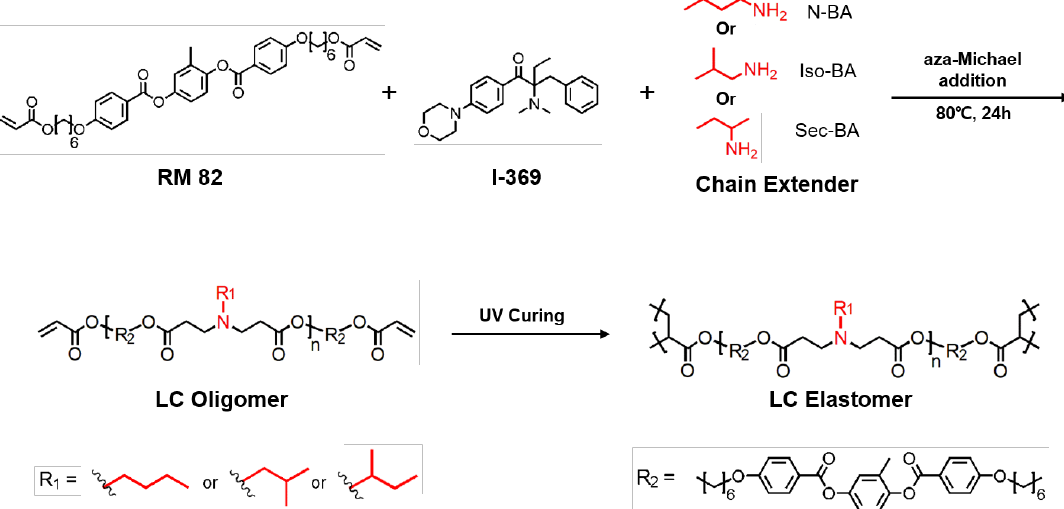
Figure 1. Synthesis of liquid crystal elastomers (LCEs) using three butylamines (n-, iso-, or sec-butylamines) as chain extenders.